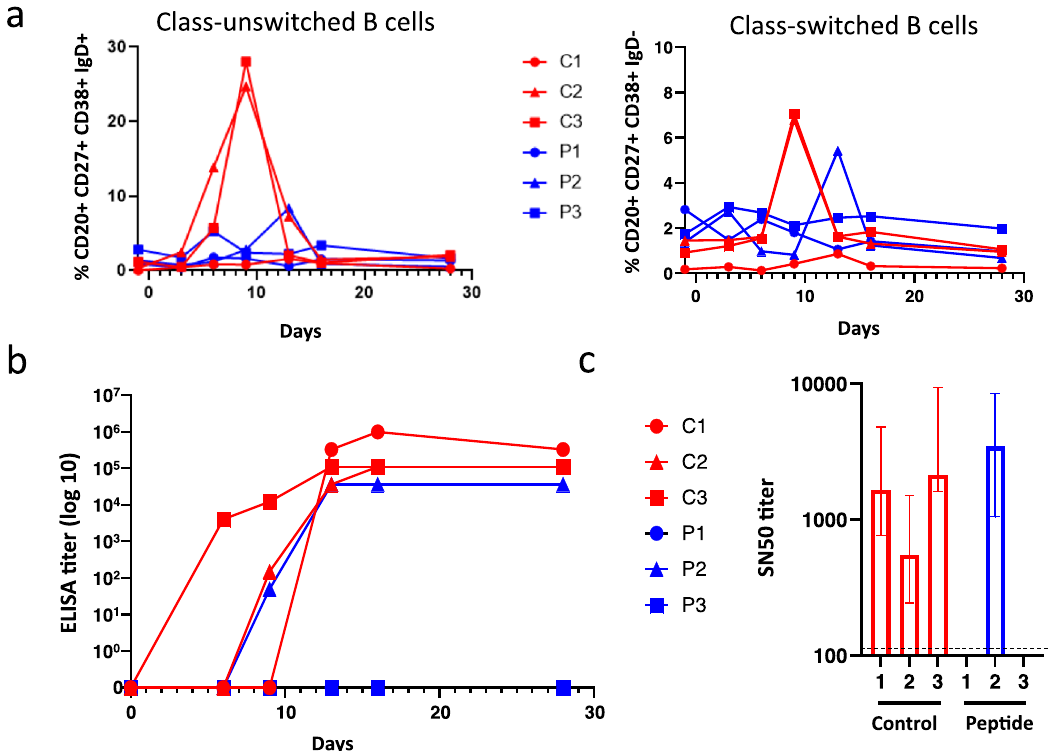
Fig.8|Establishmentofthehumoralimmuneresponseinanimalsthatdevelop MeVinfection.a Analysisofthepresenceofclass-unswithchedIgMsecretingBcells (CD20 + CD27 + CD38 + IgD + ) and switched memory B cells secreting IgG, IgA or IgE (CD20 + CD27 + CD38 + IgD - ) in the peripheral blood of NHPs, in following the neb- ulization of either 0,9% NaCl (C) or HRC4 peptide (P) and MeV infection; b Quanti fi cation of total MeV-speci fi c immunoglobulin by ELISA; plotted values present the reciprocal values of last serum dilution with detectable optical density